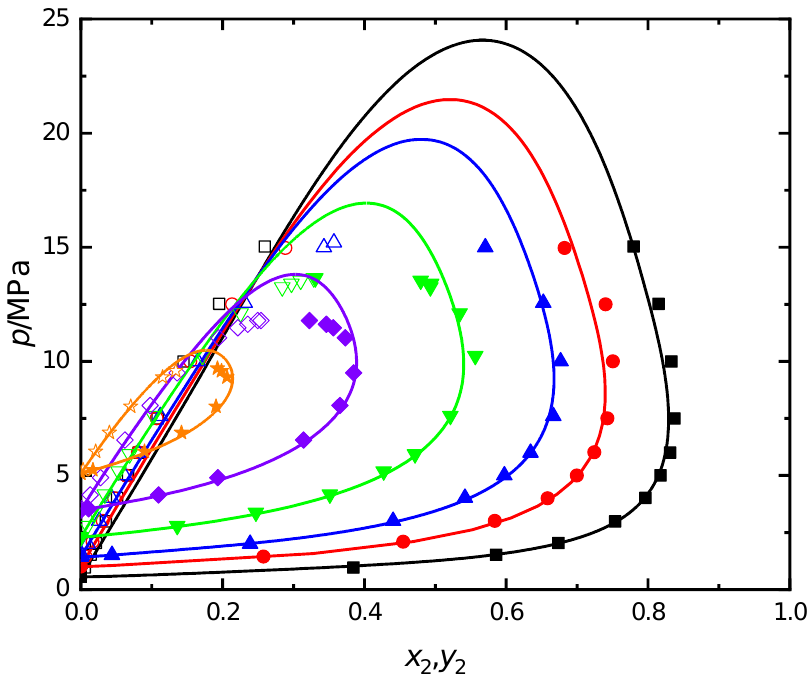
Figure 10. Vapour–liquid equilibrium for the (CO 2 (1) + N 2 (2)) system at temperatures of (black) 218 K, (red) 233 K, (blue) 243 K, (green) 258 K, (purple) 273 K and (orange) 288 K. The empty and filled-in symbols represent the bubble and dew point pressures, respectively, published by Fadiño et al. [54]. The continuous lines represent the description of the SAFT- γ Mie model. Table 14. Absolute average deviation for the bubble ( ∆ AADx ) and dew compositions ( ∆ AADy ) be- tween the SAFT- γ Mie model, the γ - ϕ model description and experimental data. N represents